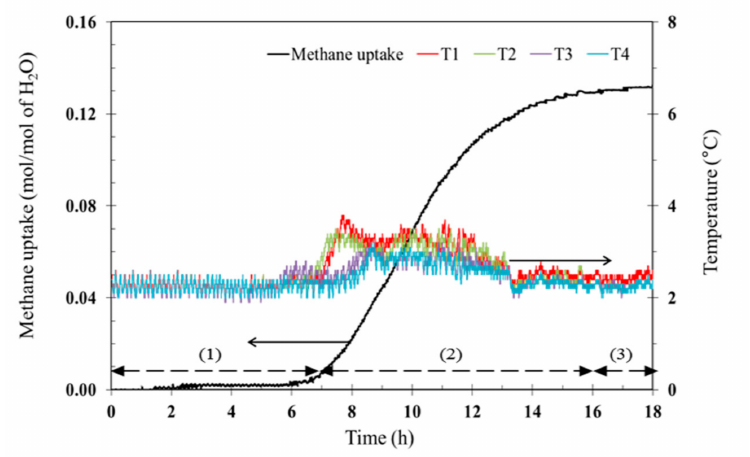
Figure 3. Gas uptake and temperature profiles of forming the TBAB semiclathrate hydrate at 2.5 ◦ C and 8 MPa in the batch operation ( w = 0.05) (Experiment 5, Table